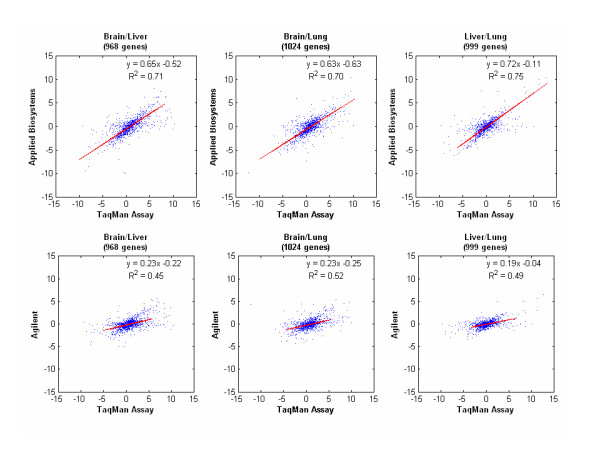
Correlation of fold change in pair-wise tissues determined by microarray platforms and TaqMan® Gene Expression Assay based real-time PCR. y-axis, fold change determined by microarrays which is defined as: For Applied Biosystems Arrays, log2 (MedianSignal_tissue1/MedianSignal_tissue2); for Agilent arrays, log2(MedianSignal_tissue1/MedianSignal_UHR)- log2(medianSignal_tissue2/MedianSignal_UHR); x-axis, fold change determined by real-time PCR, which is defined as ΔΔCt = (Ct_tissue2-Ct_PPIA)-(Ct_tissue1-Ct_PPIA). For each pair-wise comparison, genes were filtered based on real-time PCR detection thresholds (detectable in at least 3 out of 4 technical replicates in each tissue and detectable in both tissues, the number of genes are shown in the parentheses). A robust linear regression fitting and the corresponding R2 value are presented in each plot.